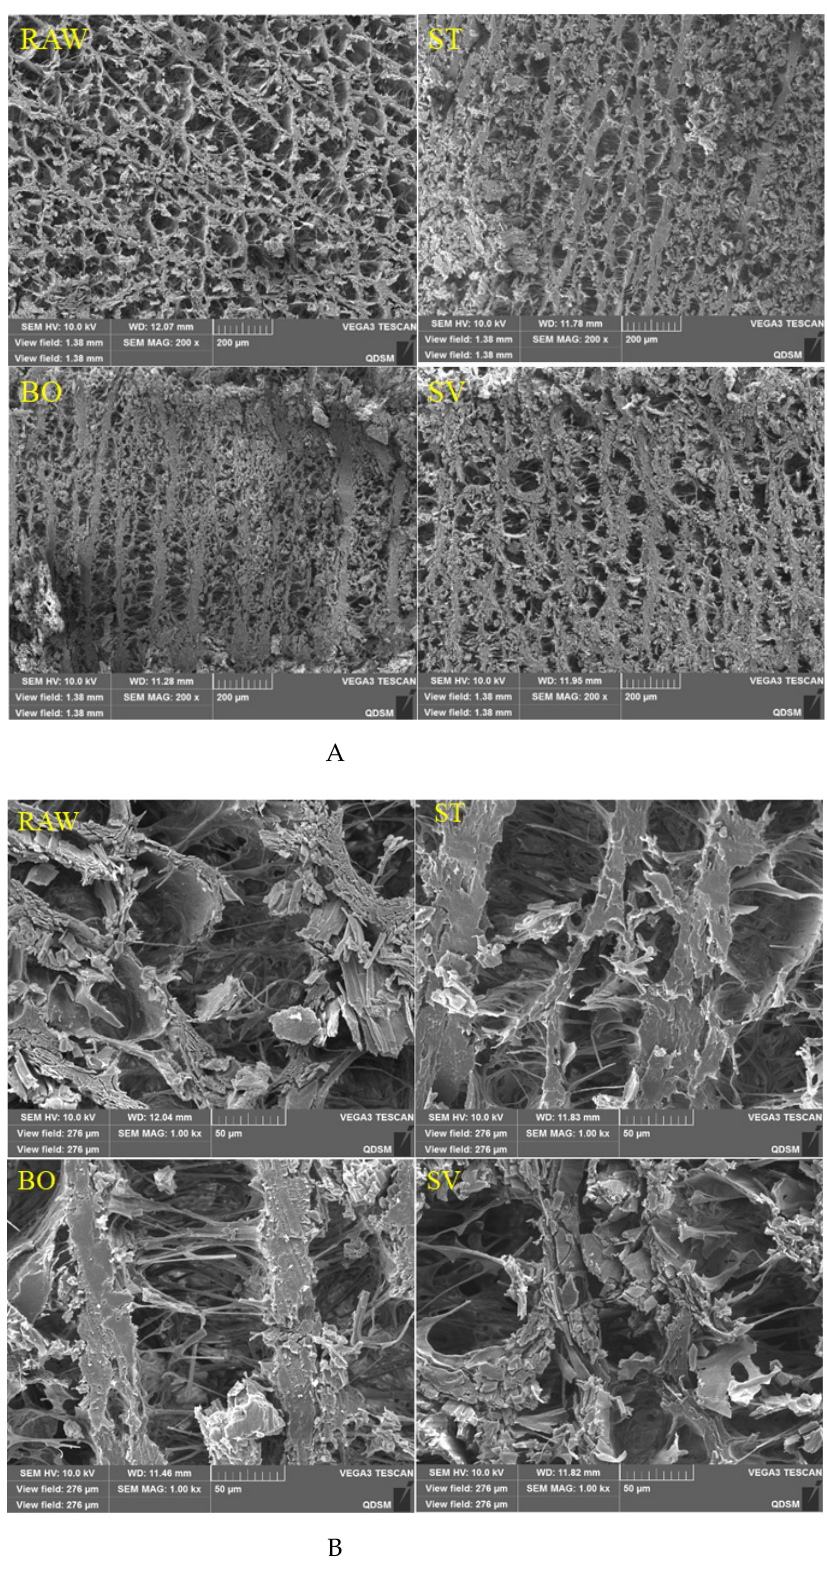
Figure 6. Scanning electron microscopy images of microstructures of squid ( Symplectoteuthis oualaniensis ) mantle muscle before and after treatment of RAW, ST, BO, and SV ( A : magnification, 200×; B : magnification, 1000×;). RAW: raw squid; ST: steaming; BO: boiling; SV: sous vide.